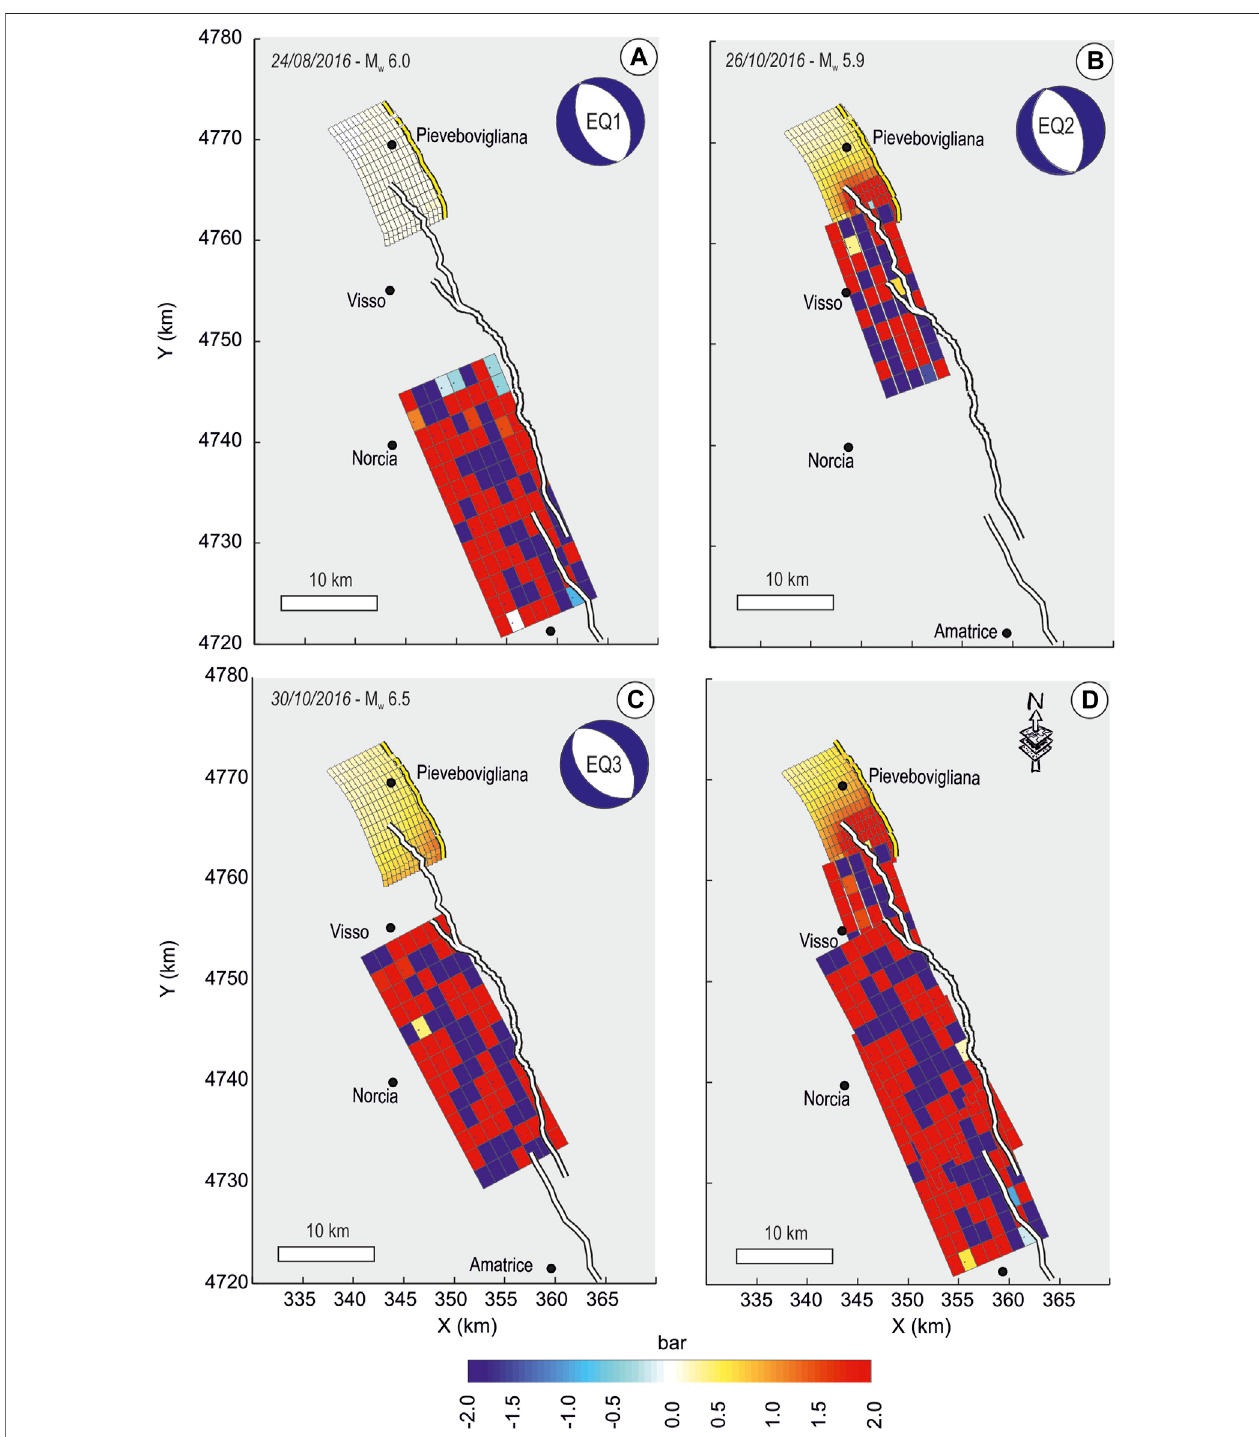
FIGURE12| CoulombstresstransferonPievebovigliana(PBF)faultinducedbytheoccurrenceofthemaineventsoftheNorciaseismicsequenceEQ1,EQ2,EQ3. Source parameters and the distribution of variable slip are from Chiaraluce et al. (2017). The yellow and white lines represent the traces of Gorzano-Vettore- Pieveboviglianafaultsystems. (A) EQ1seismicsourcevsPBF (B) EQ2seismicsourceonPBF (C) EQ3onPBF (D) CumulativestresstransferinducedbyEQ1 – 3onPBF.